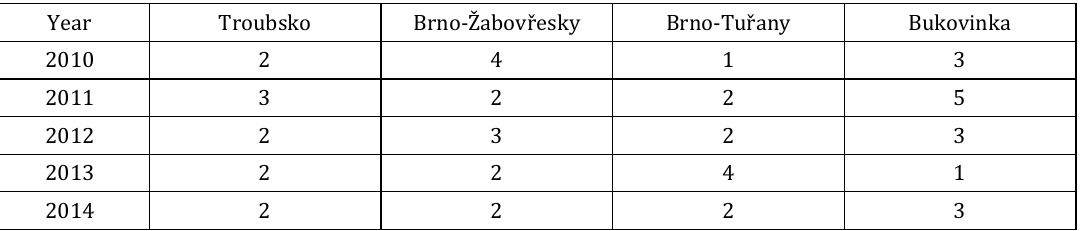
Fig. 5. The number of torrential rains at Brno-Žabovřesky meteorological station (2000 – 2014) Table 1. Number of torrential rains in Brno (2010 – 2014)